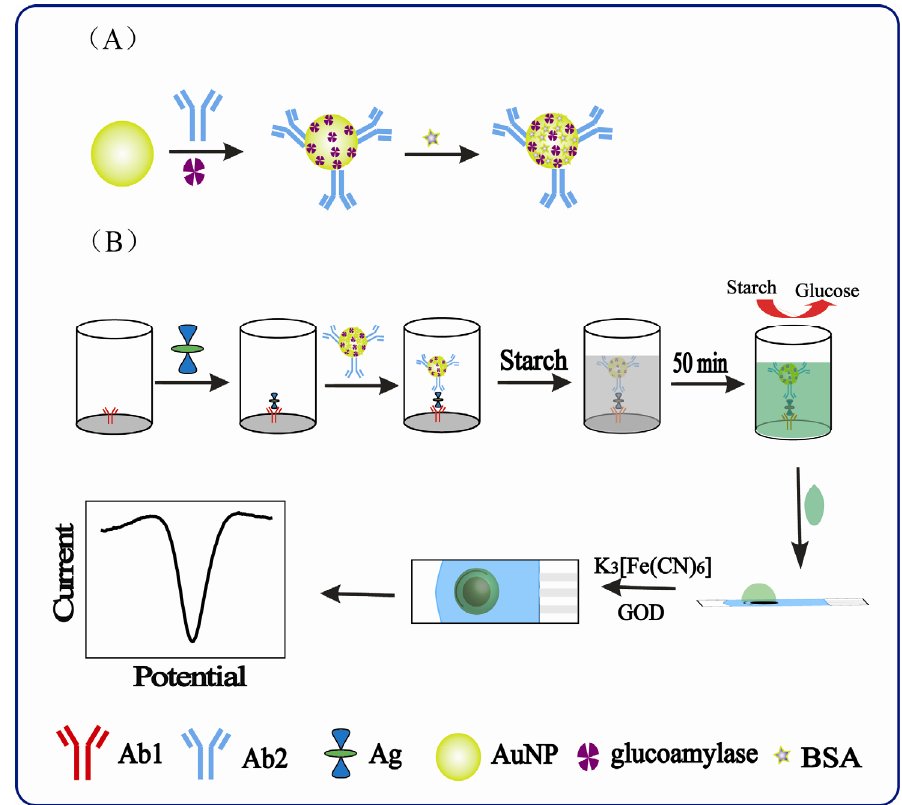
Scheme 1. Schematic representation of ( A ) the preparation of bioconjugates, and ( B ) ELISA and measurement